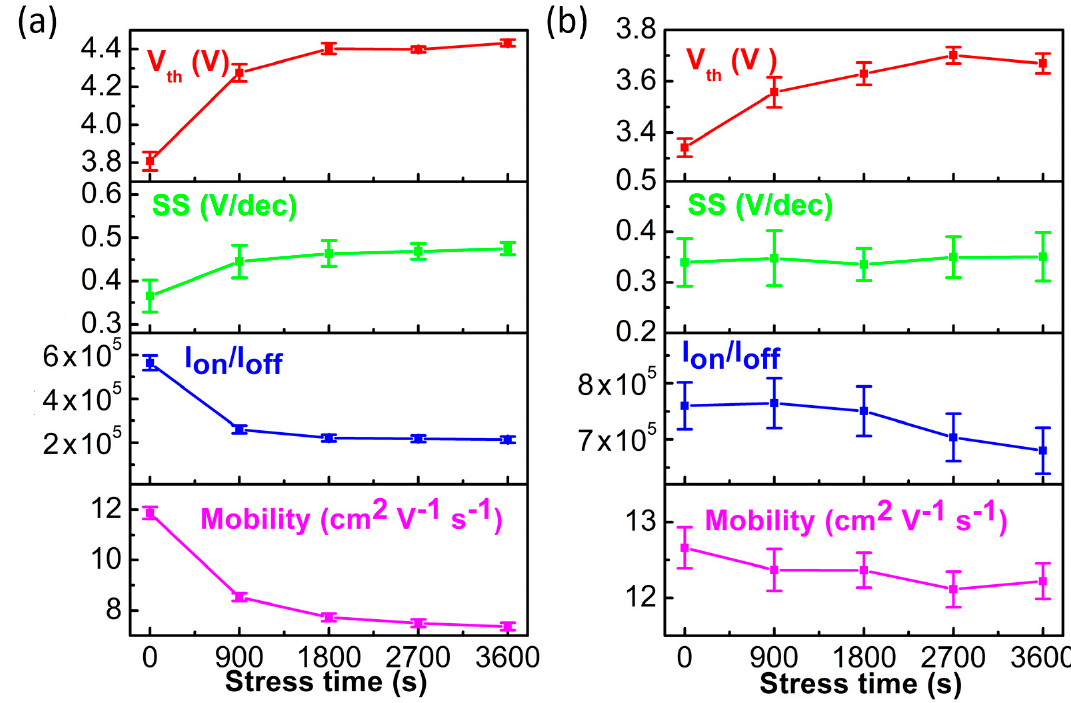
Figure 7. The trend of electrical characteristics of the TFT with ZrO 2 film fabricated by 0.3 M precursor spin-coating 6 times. ( a ) Positive bias stress. ( b ) Negative bias stress.